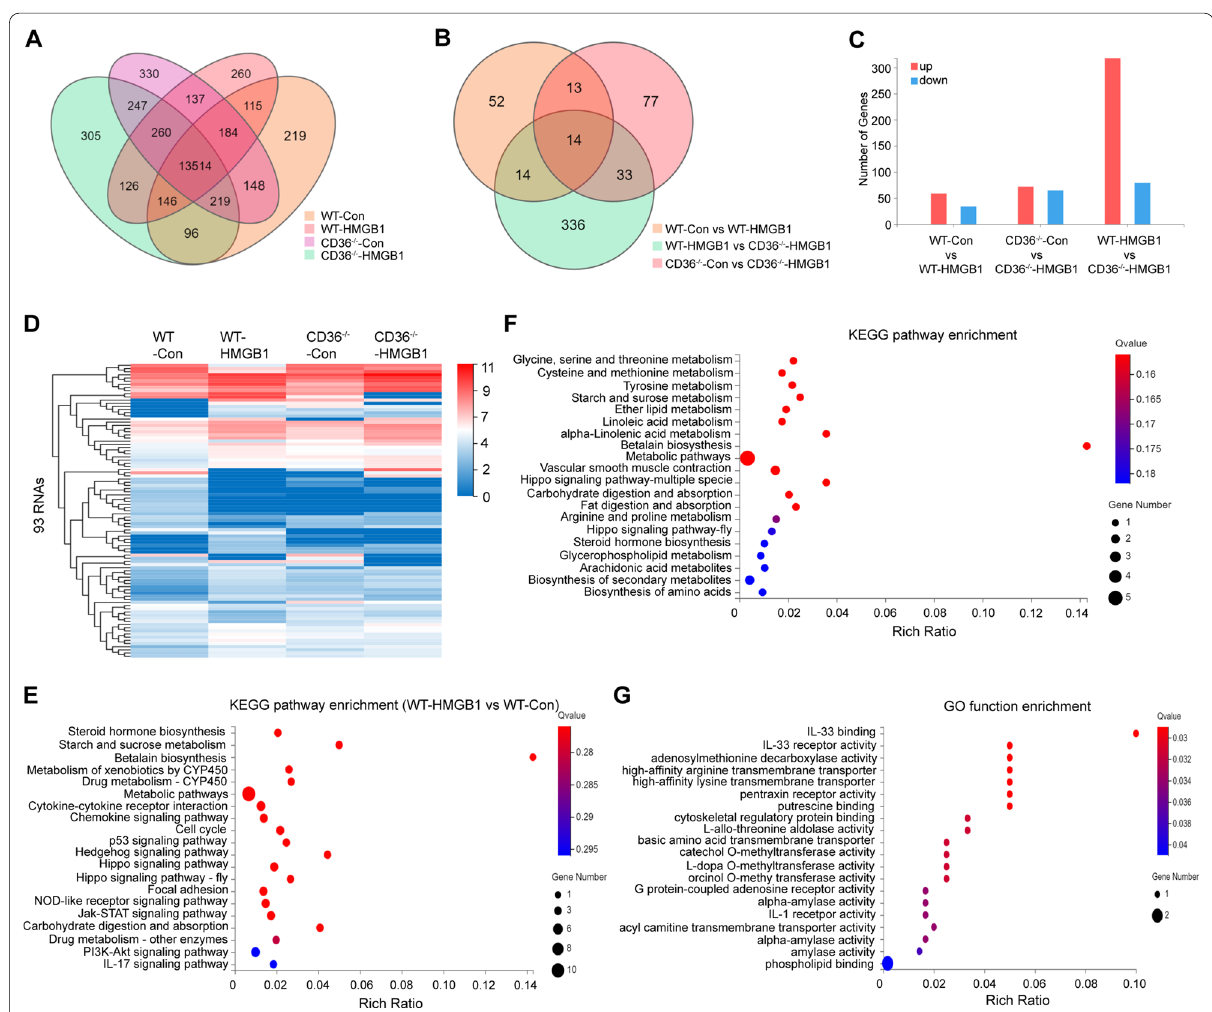
Fig.6 RNA-seq of control or HMGB1 treated BMDM from WT or CD36 − / − mice. A The VENN/UpSetR graph of RNA-seq for four groups of cells. B The different expression of genes between different comparison groups via VENN/UpSetR figure. C The significant differentially expressed genes (DEGs) detected were statistically plotted in three comparison. D The expression heat map of 93 genes in four groups of cells. E KEGG pathway enrichment bubble chart of the significant differentially expressed genes between WT-Con and WT-HMGB1 group. F KEGG and G GO function pathway enrichment bubble chart of RNAs significantly upregulated in HMGB1 treated BMDM from WT, not CD36 − / − mice. |log2FC|>